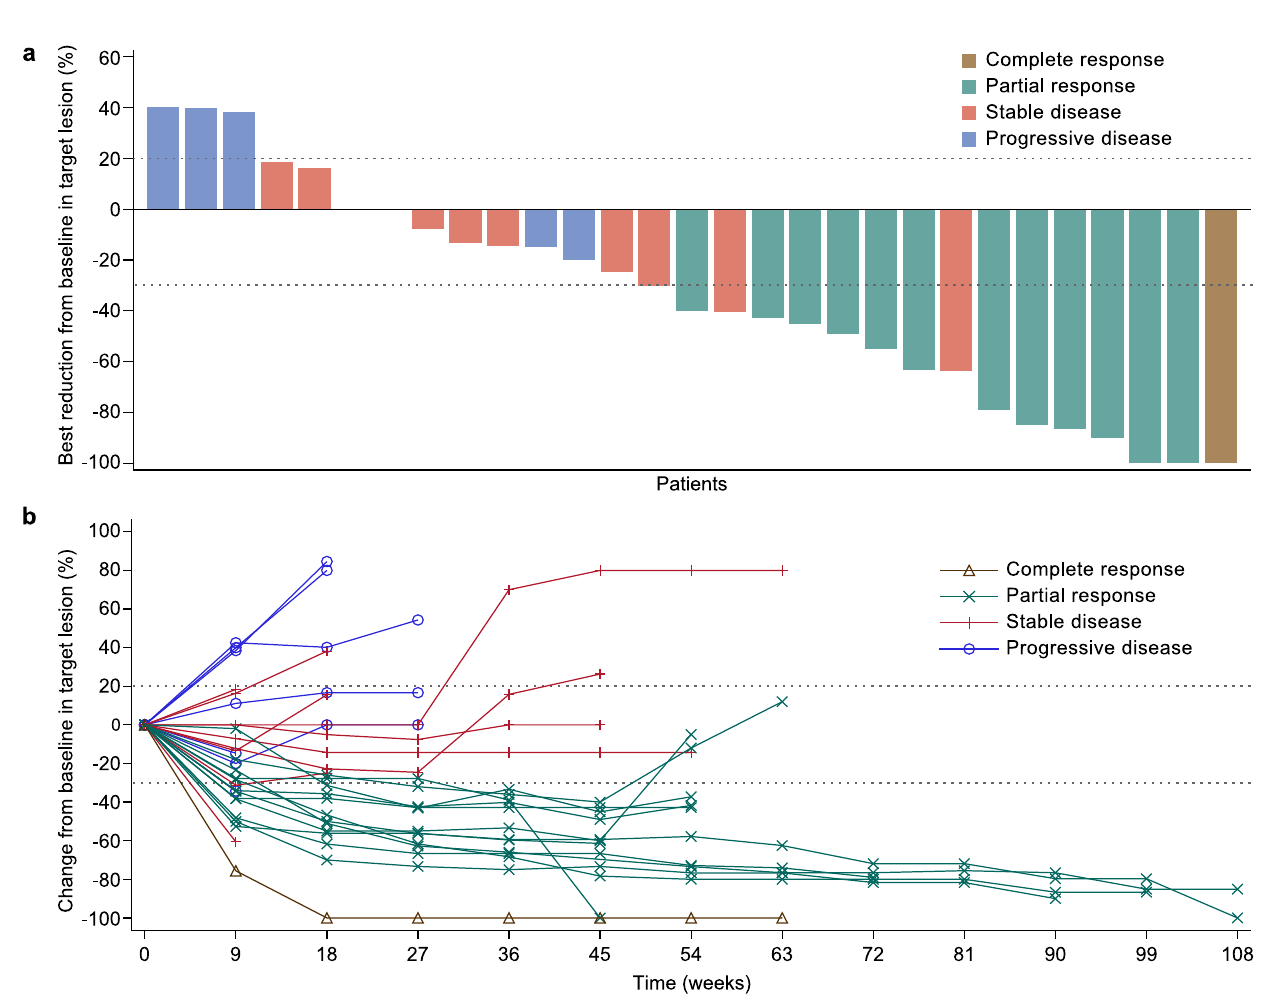
tumor responses in 29 patients who had at least one post-baseline scan of target lesion.Inonepatient,thetargetlesionhadnotbeenmeasuredatpost-baselinebut a new lesion appeared during treatment. This patient was determined to have progressive disease and was not included in the waterfall and spider